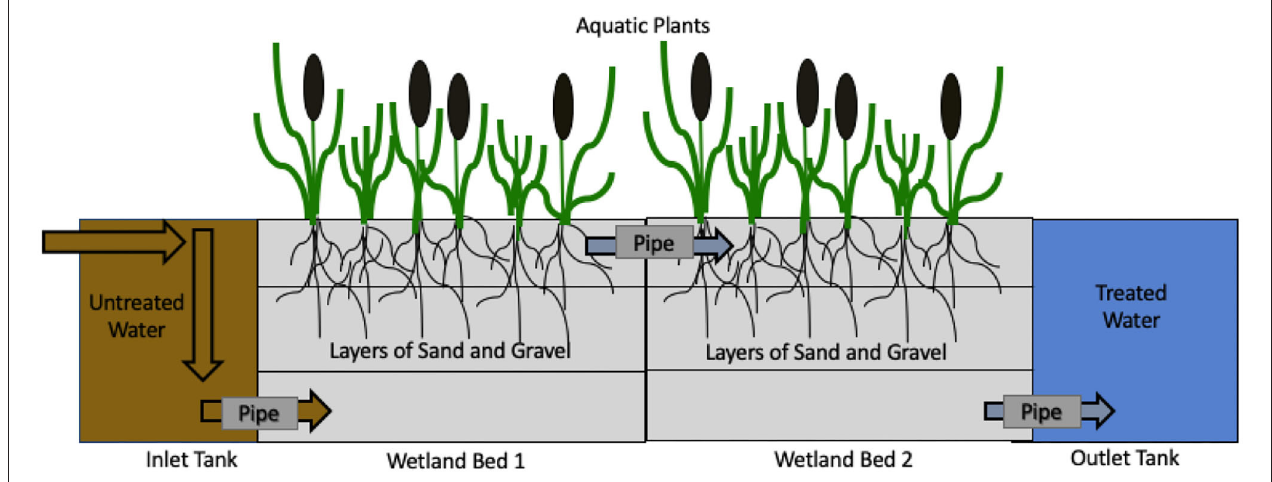
FIGURE 1 | Basic design of horizontal flow CW implemented in the